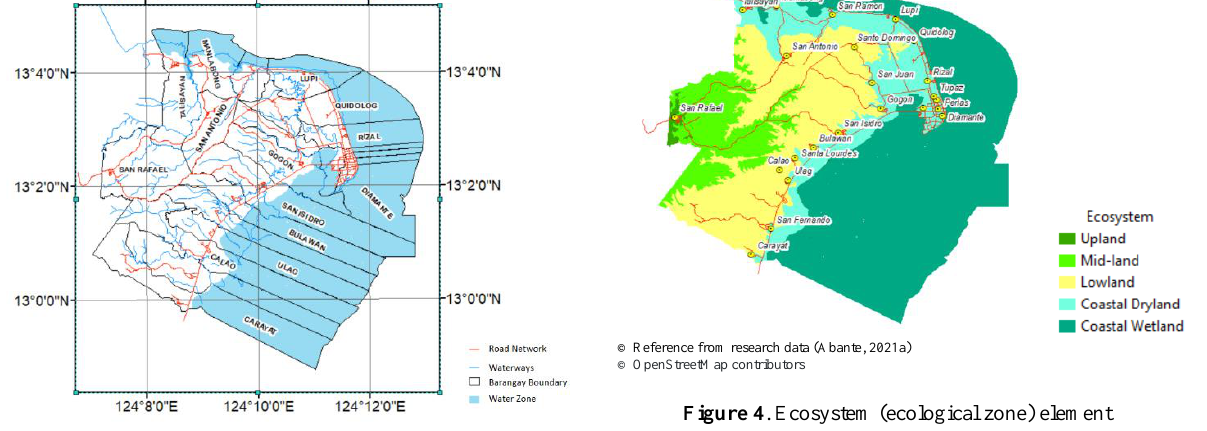
Figure 2. Prieto Diaz Politico-Administrative Boundary